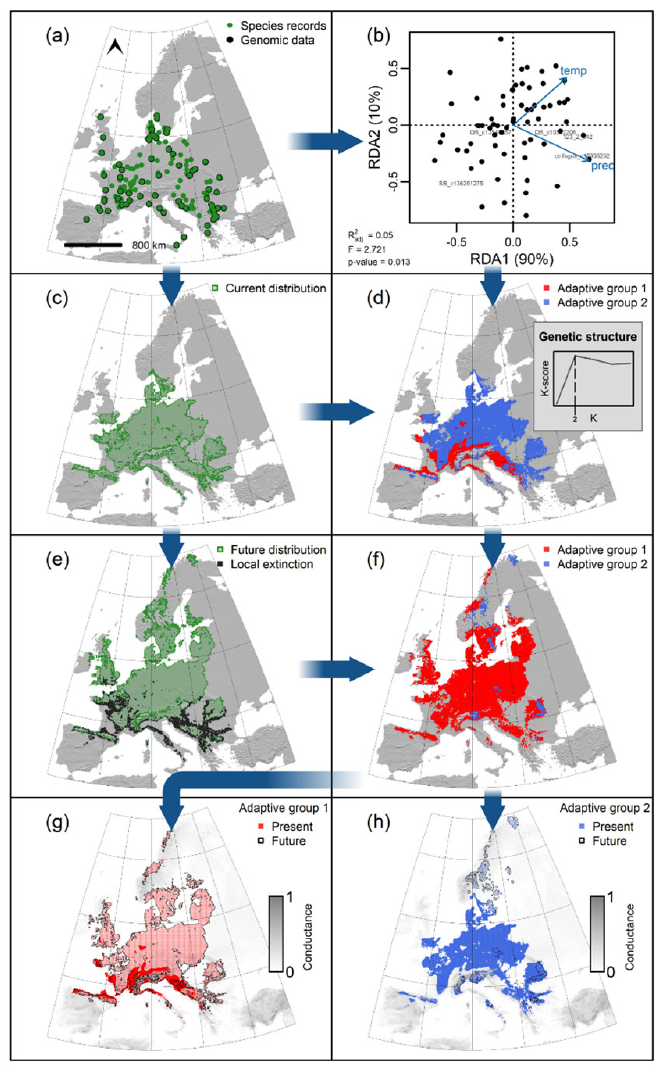
Figure 1. General framework integrating species distribution modeling and landscape genomics to predict the optimal spatial distribution of adaptive diversity in the future. Both approaches start from the spatial occurrences of either the species observations or the genotyped individuals or populations ( a ). A species distribution model can be derived based on the observed species records and some ecologically relevant habitat features ( c ), and it can project into the future based on specific climate change scenarios ( e ). In contrast, a landscape genomic analysis (e.g., RDA) can be devised to outline a set of candidate SNPs under selection ( b ) and to estimate the adaptive landscape of the species based on a previously inferred species distribution ( d ) [72]. The adaptive genetic structure identified can be projected into the future to outline the optimal distribution of adaptive diversity so as to tackle climate change and guarantee optimal fitness in the future ( f ). Finally, corridors for adaptive gene flow can be identified based on a conductance surface to inform forest management and conservation strategies ( g , h ).